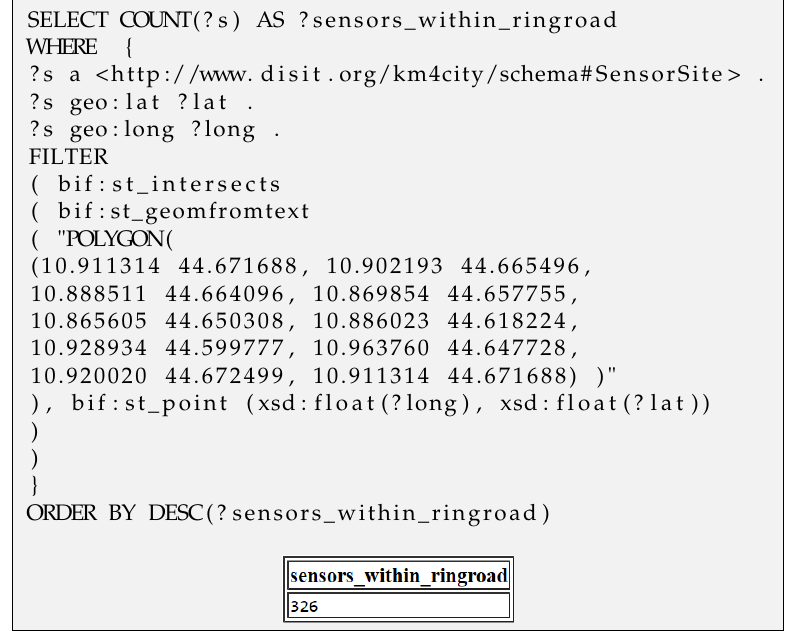
Figure A4. SPARQL query showing the list of sensors located on the street named “Ronda Hispanidad” and the number of vehicles counted by these sensors on 8 January 2019.